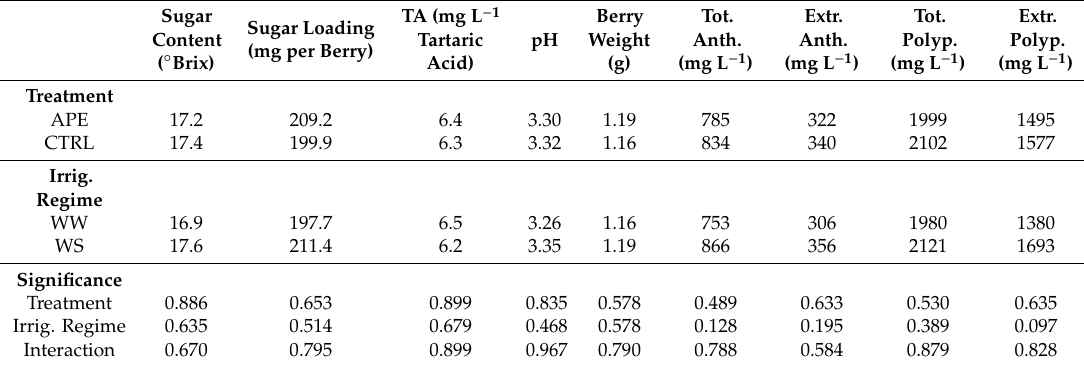
Table 5. Two-way ANOVA ( p < 0.05) for berry composition